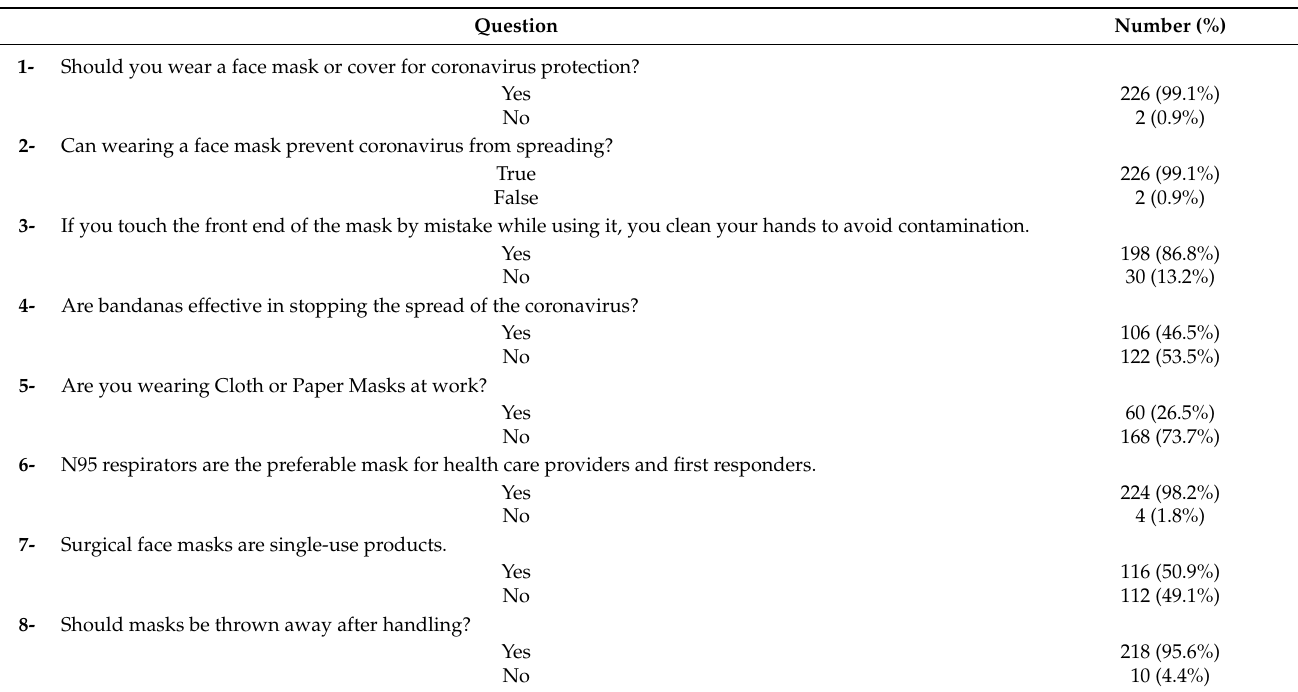
Table 3. Perceptions about face